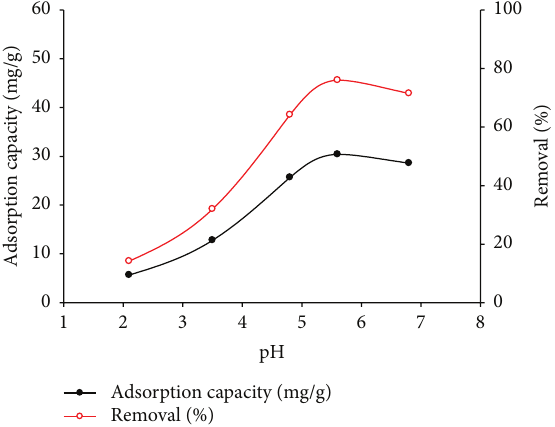
Figure 6: Effect of the pH on the adsorption of copper by CaHBSW.